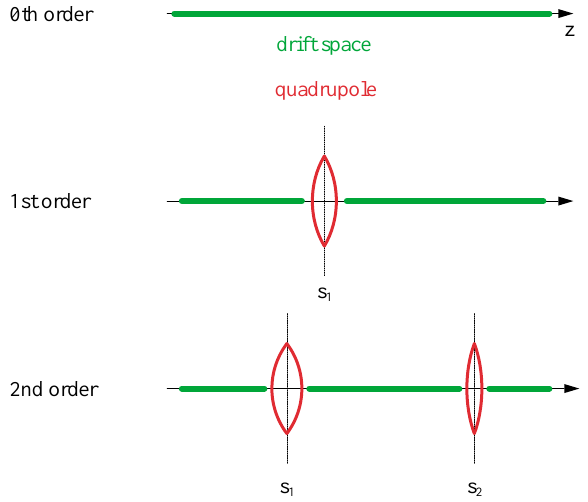
FIG. 1. (Color) Visualization of the contributions M n from per- turbation theory according to the number of interactions n of the beam with the quadrupole strength of the magnet.